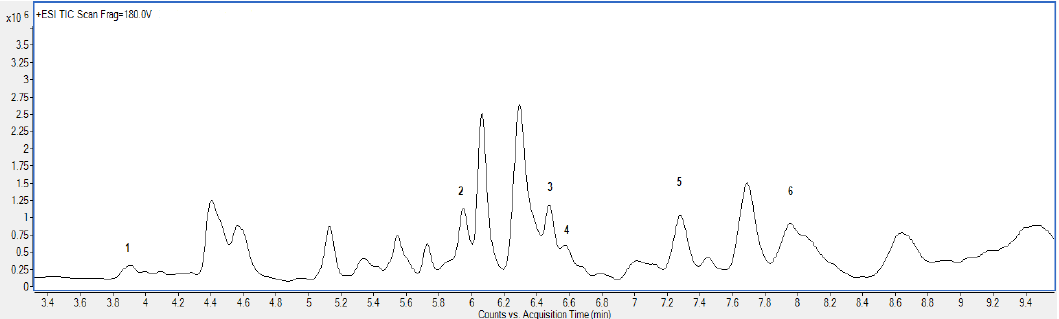
Figure 2. Magnified total ion chromatogram of the extract of T22-treated plants recorded in positive mode. Putatively identified metabolites and the corresponding peak numbers in the figure are reported in Table 1. Table 1. Putatively identified metabolites in parsley extract obtained by LC-MS analysis. Data include peak number as reported in Figure 2, retention time, experimental and theoretical mono-isotopic mass and molecular formula. N.